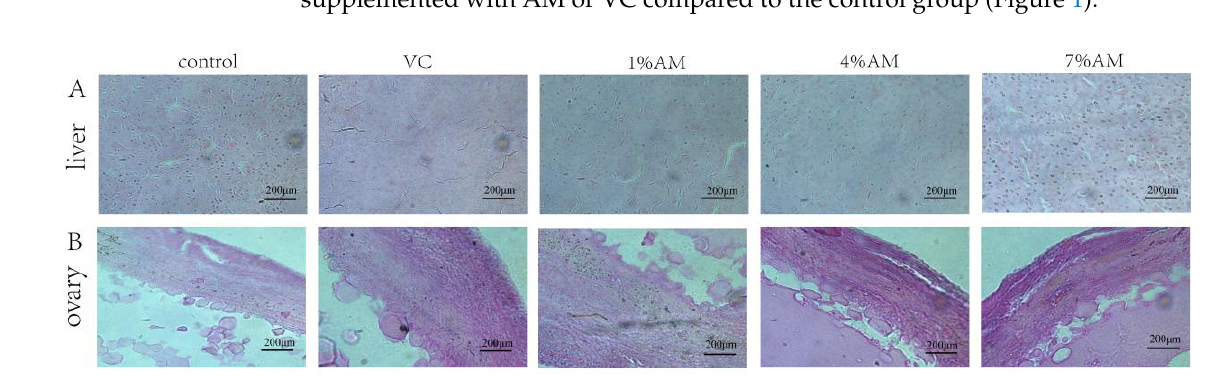
Figure 1. Effects of feed supplemented with AM on liver and ovary histology of laying hens. ( A ) Liver tissue morphology in different groups; ( B ) Ovary tissue morphology in different groups. The bar represents 200 μm.